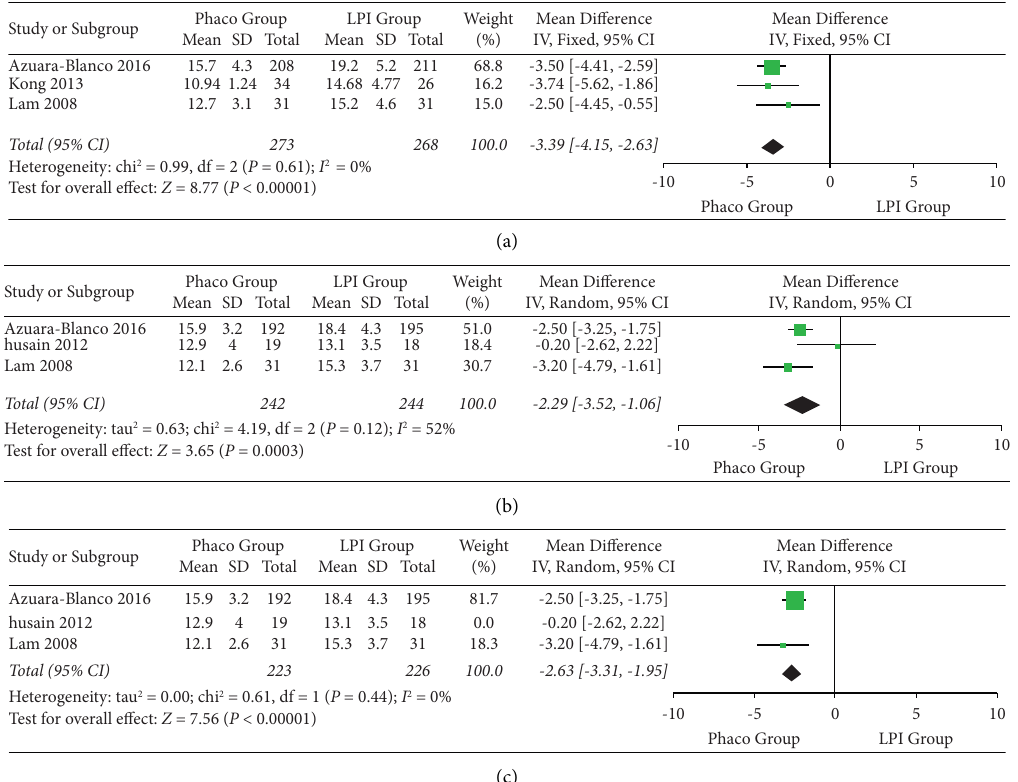
Figure 3: Forest plots comparing the IOP between the Phaco groups and LPI groups at diferent follow-up times. (a) Six months after the operation. (b) Twelve months after the operation. (c) Twelve months after the operation (excludes the study of Husain et al. [26]).